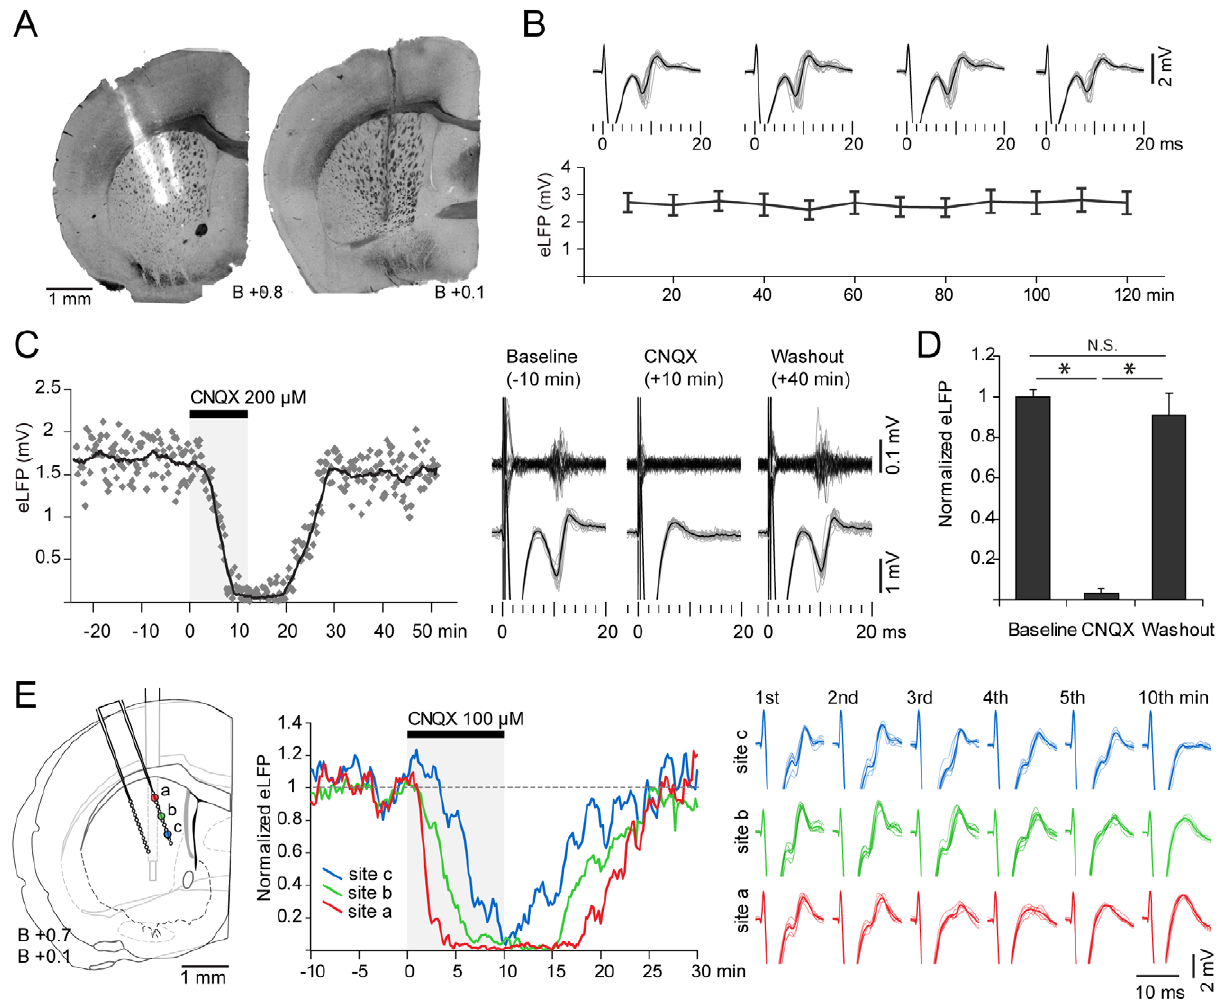
Figure 5. Local administration of CNQX blocks synaptic responses in the striatum. A. Histological sections showing the location of the multichannel electrode (left) and microdialysis probe (right) in a representative experiment. B. Striatal field responses evoked by stimulating the prelimbic cortex remained stable for hours under continuous infusion of ACSF through the microdyalisis probe (n=3). C. Left: Time course of the blocking effect of CNQX on striatal field responses evoked by cortical stimulation in a representative experiment. Each point is the amplitude of a single evoked response, which was evaluated every ten seconds during the experiment. The superimposed line corresponds to the smoothed data with a moving average window (20 samples). Right: Field potential responses corresponding to the individual trials depicted in gray, and multiunit activity recorded from the same electrode contact, before, after 10 minutes of CNQX infusion, and after 40 minutes of washing out with ACSF. Data are from the experiment shown at the left. D. CNQX administration (200 m M) almost completely blocked the striatal field response to cortical stimulation (* p , 0.001, Tukey post-hoc test, repeated measures ANOVA, N=4). E. Left: Histological reconstruction showing the location of three recording sites in the multichannel electrode ( a, b, c ) and the microdialysis probe in one of the CNQX experiments. Middle: Time course of CNQX effect at sites a, b and c . Note that CNQX reached first the closest recording site a than the more distant sites b and c . Distance between illustrated recording sites: 400 m m. Right: Striatal field response during the first 5 minutes and at the 10th minute of CNQX infusion in the same experiment, showing that by the fourth minute, response in site a was abolished but remained almost unchanged 800 m m away in site c . Note that the time course of CNQX effect depends on the location of the recording electrode and not on the basal amplitude of the response (compare site a with